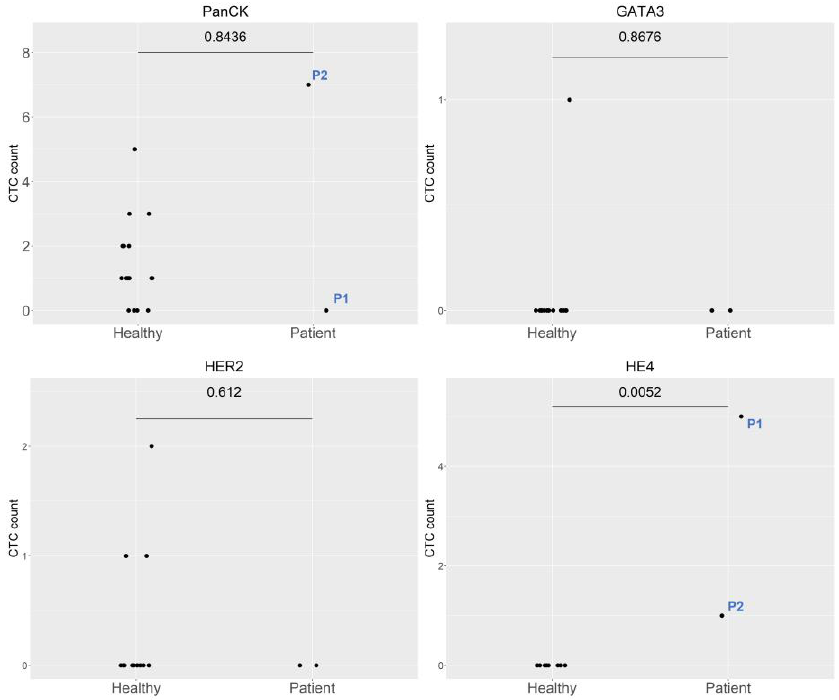
Figure 4. Comparison of the expression of different molecular markers between healthy controls and ovarian cancer patients. Abbreviations: P1, Patient 1 and P2, Patient 2.